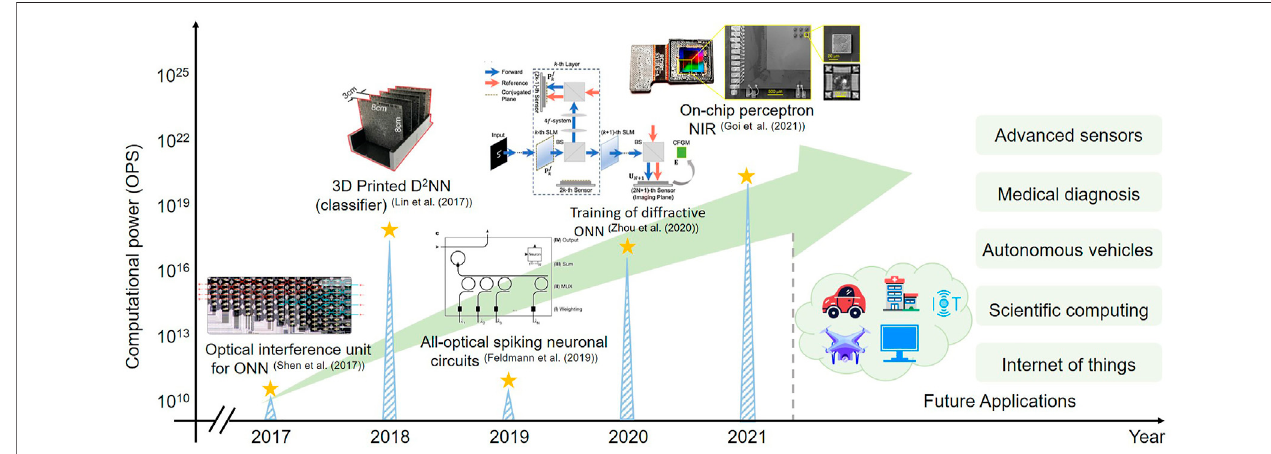
FIGURE 5 | Development of photonic chip computing power and their representative application.